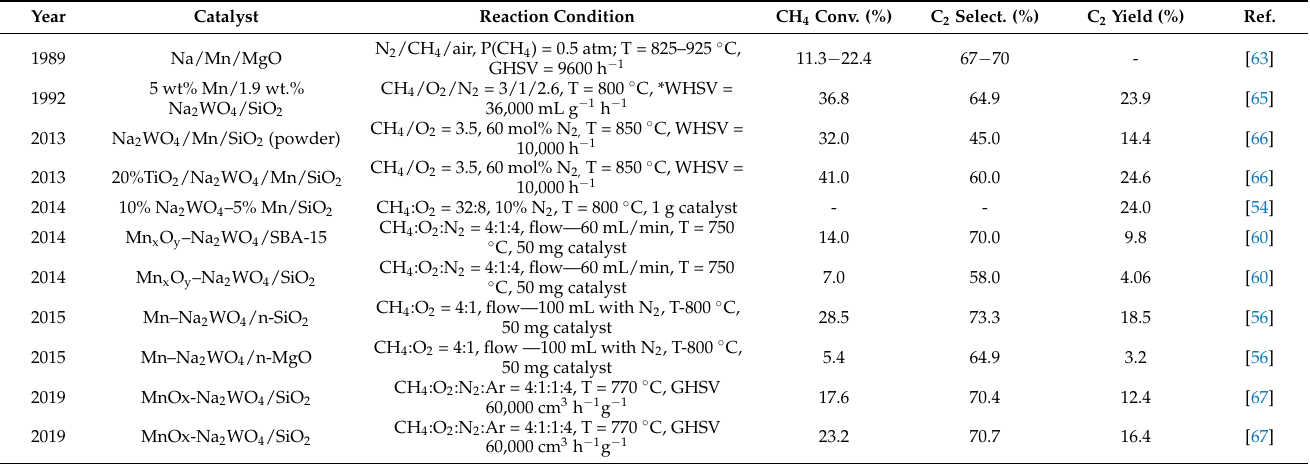
Figure 6. Catalytic OCM mechanism on Mn 2 O 3 /Na 2 WO 4 /SiO 2. Reproduced with permission from [53]. Copyright 2019 ACS. Table 2. OCM reaction over various Mn-Na2WO4 supported